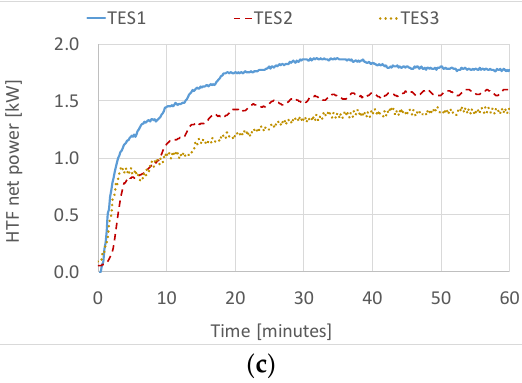
Figure 9. A summary of the results three-fluids HEX mode ( a ) temperature at the condenser, ( b ) pressure at the condenser and evaporator, and ( c ) cooling load at the evaporator.